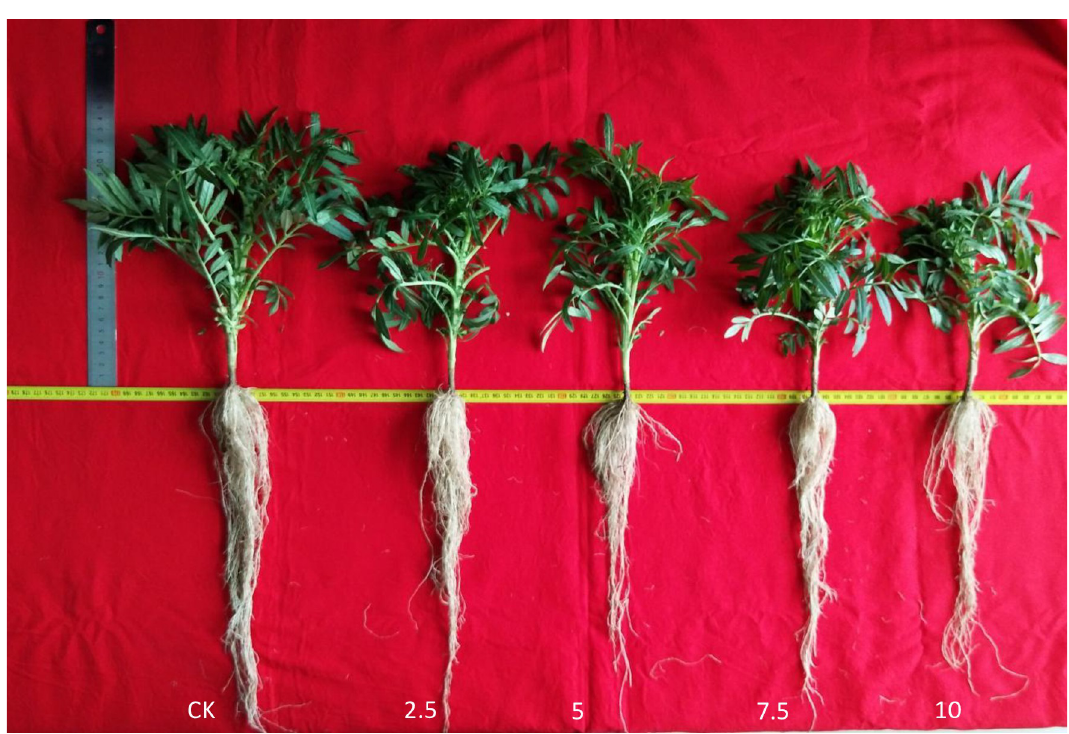
Fig 1. Growth of T . erecta at different R . typhina root extract concentration after 60 days. CK, 2.5, 5, 7.5, 10 represent different extract concentrations of 0, 2.5, 5, 7.5, 10 mg � mL -1 , respectively.